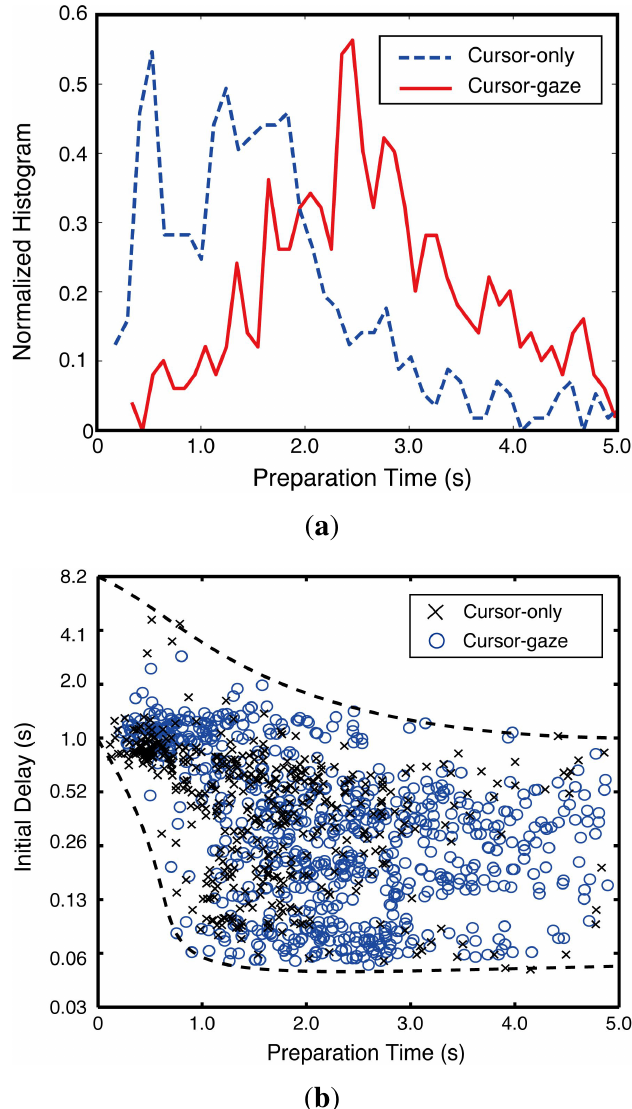
Figure 9. Influence of preparation time. ( a ) Normalized histogram of preparation time; ( b ) initial delay depending on preparation time (the vertical axis is drawn in binary logarithmic